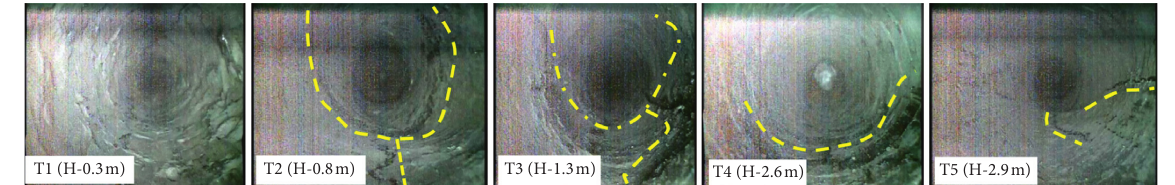
Figure 4: Observation results of the roadway surrounding rock fracture in the extremely thick coal seam.